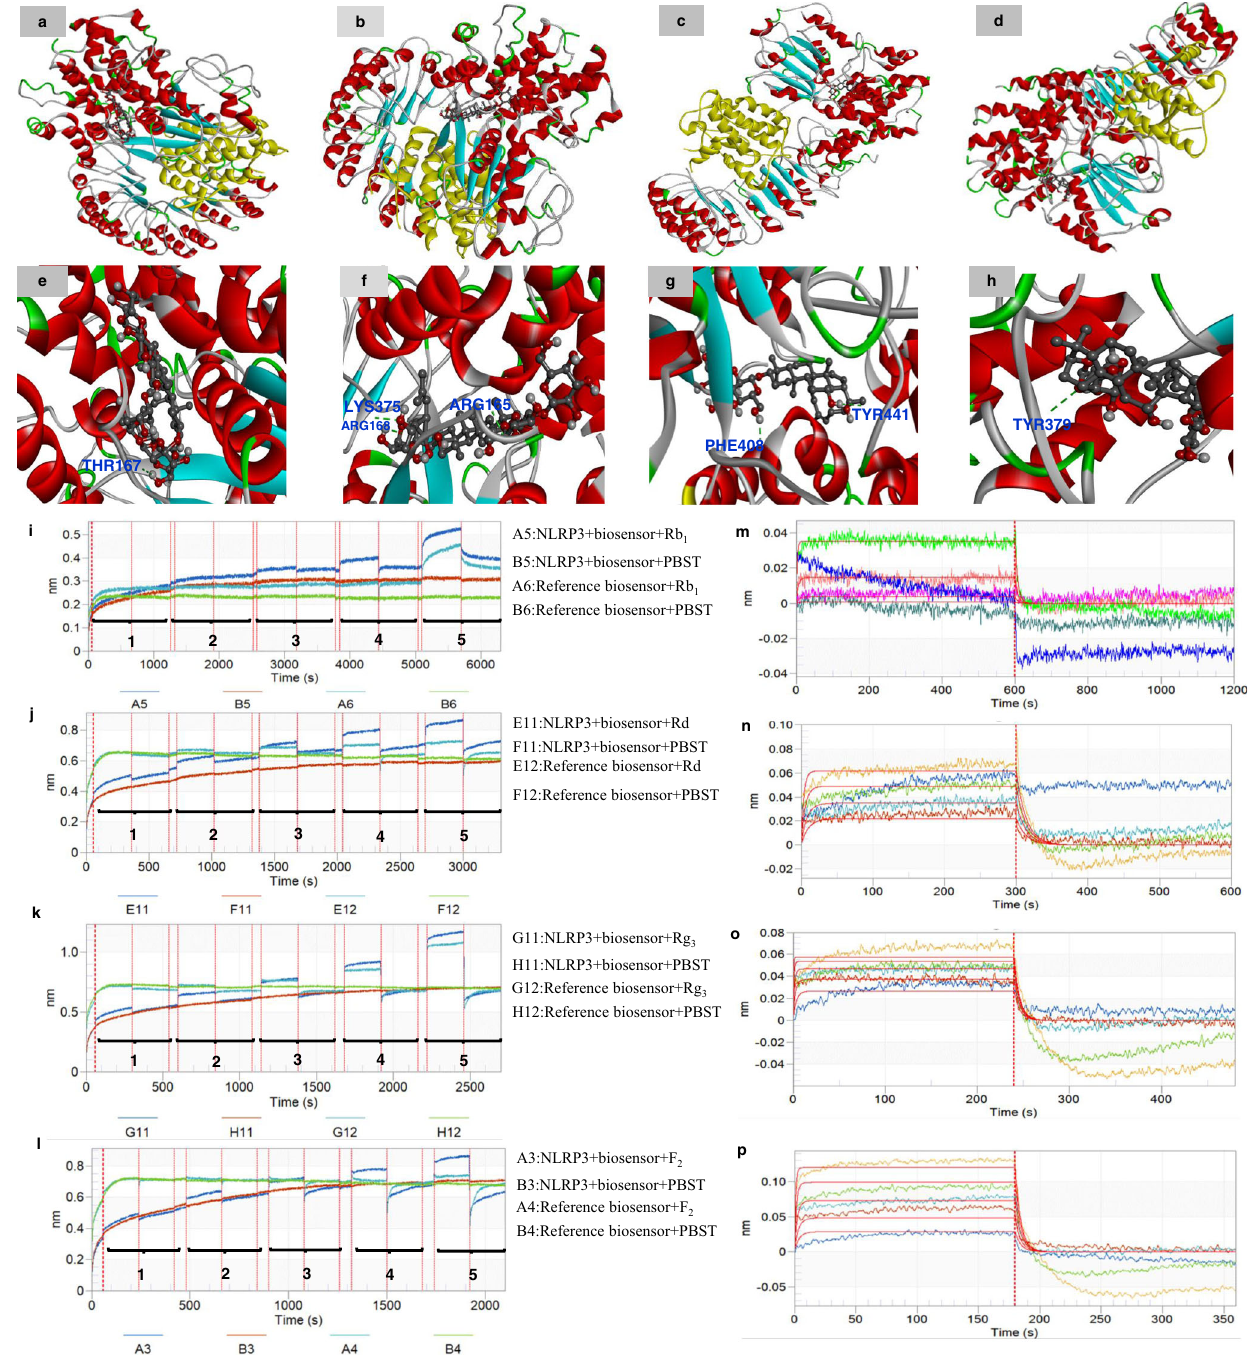
Fig. 4 Binding af fi nity of the ginsenoside analogues to NLRP3 was evaluated by molecular docking and bio-layer interferometry. Molecular docking predicted the binding sites of ginsenoside analogues: a , e Rb 1 , b , f Rd, c , g Rg 3 , d , h F 2 to NLRP3. The protein structure is demonstrated in ribbon format while ligand is represented in ball and stick format. Note: Red areas mean oxygen atom, grey areas mean carbon atom, blue areas mean nitrogen atom, white areas mean hydrogen atom and green areas mean other. The green dotted lines represent hydrogen bonds. Bio-layer interferometry validated the binding af fi nity of the ginsenoside analogues Rb 1 , Rd, Rg 3 , F 2 to NLRP3. Typical kinetic characterization of NLRP3 to various concentrations of analogues by using BLI assay ( n = 5). i Biosensors were exposed to various concentrations (marked 1 – 5) of Rb 1 solution (1.44, 7.21, 36.1, 180.3, 901.7 μ M) for association (600 s) and dissociation (600 s). j Biosensors were exposed to Rd solution (9.06, 18.1, 36.3, 72.6, 145.2 μ M) for association (300 s) and dissociation (300 s). k Biosensors were exposed to Rg 3 solution (7.18, 14.4, 28.7, 57.4, 114.8 μ M) for association (240 s) and dissociation (240 s). l Biosensors were exposed to F 2 solution (14.2, 28.3, 56.6, 113.2, 226.4 μ M) for association (180s) and dissociation (180 s). Association and dissociation steps are divided by the dotted line. Panels ( m – p ) represent Rb 1 , Rd, Rg 3 and F 2 in the association and dissociation steps in order to fi t results globally with a 1:1 binding model and get the best values of k on , k dis and K D